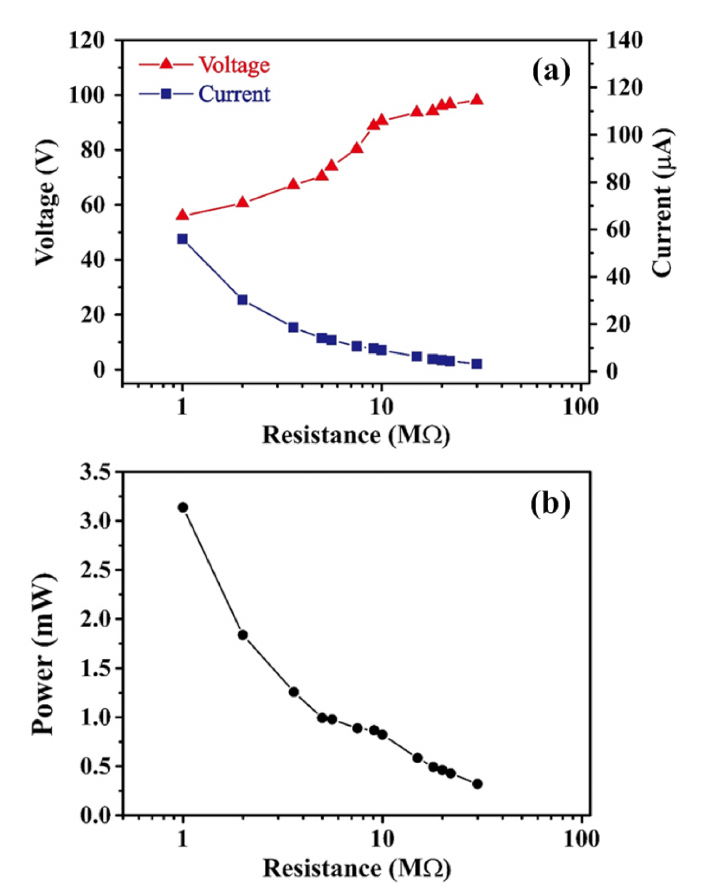
Figure 9. Effect of external load resistance on ( a ) output voltage and current and ( b ) output power as the load resistance is increased from 1 to 30 M Ω